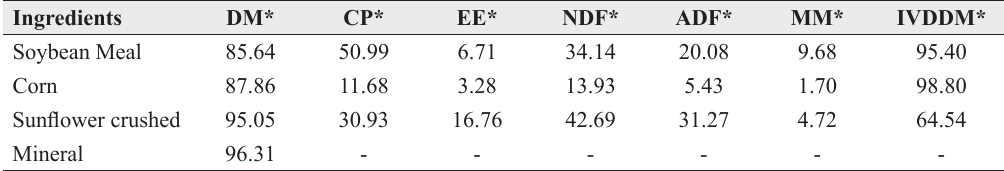
Chemical composition of ingredients used in concentrated for